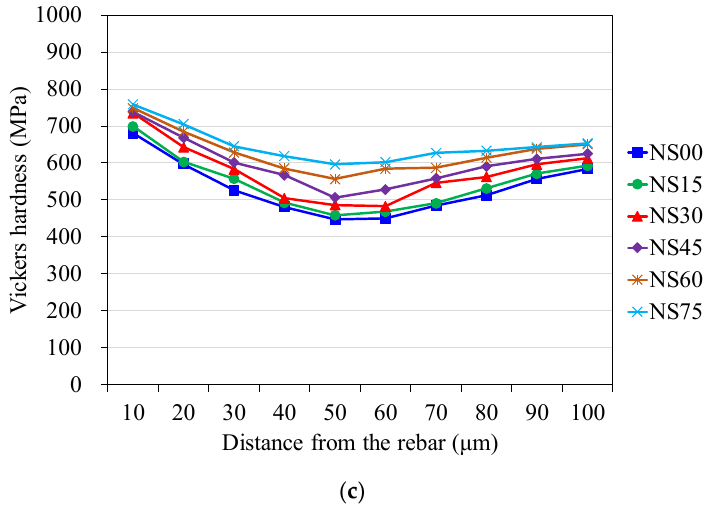
Figure 3. Measured Vickers hardness of normal aggregate concrete at ages of ( a ) 28 days, ( b ) 56 days and ( c ) 91 days.